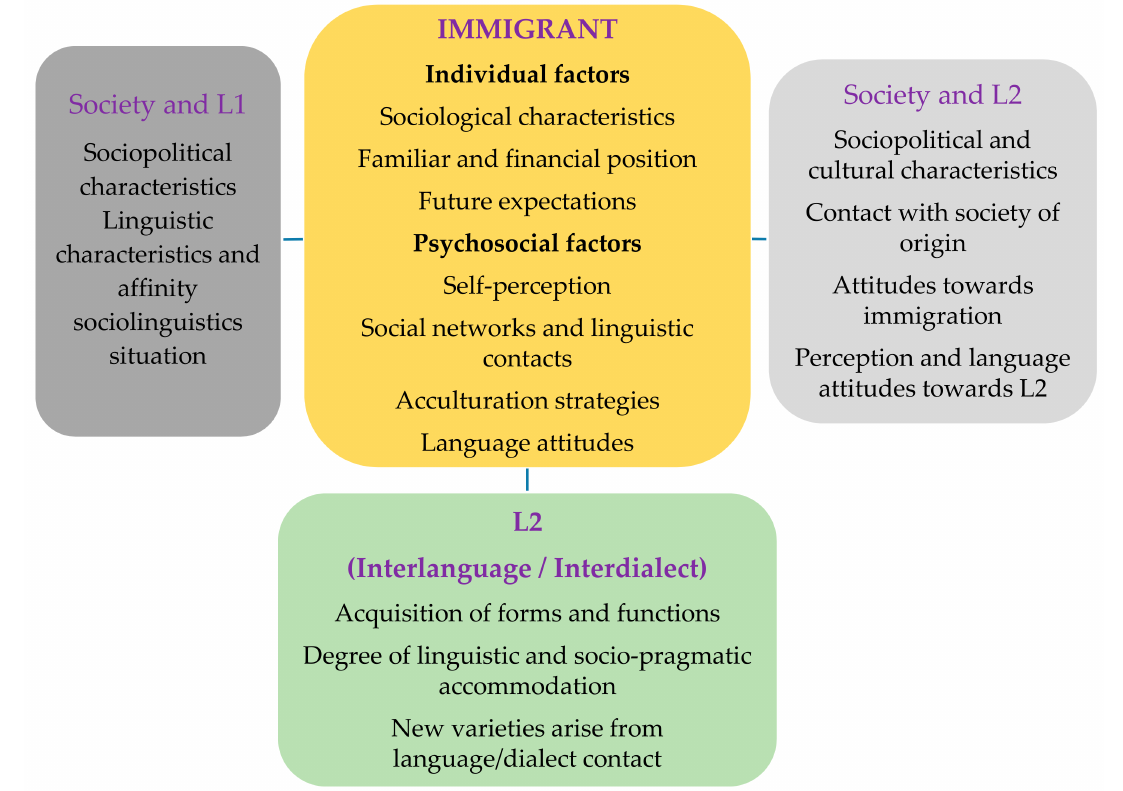
Figure 3. Holistic model of the sociolinguistic integration of immigrants. (Paredes Garc í